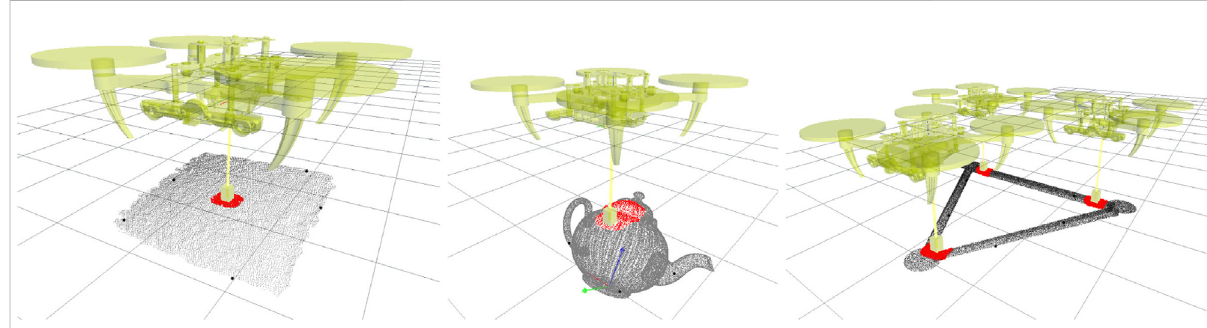
FIGURE 1 Learned contact models. (left) shows a central contact with a fl at surface, i.e. top face of the Fedex box, (middle) shows a curved contact on a teapot, and (right) a triangular con fi guration for three drones. The red points represent the sub-sampled local area of the surface used to learn